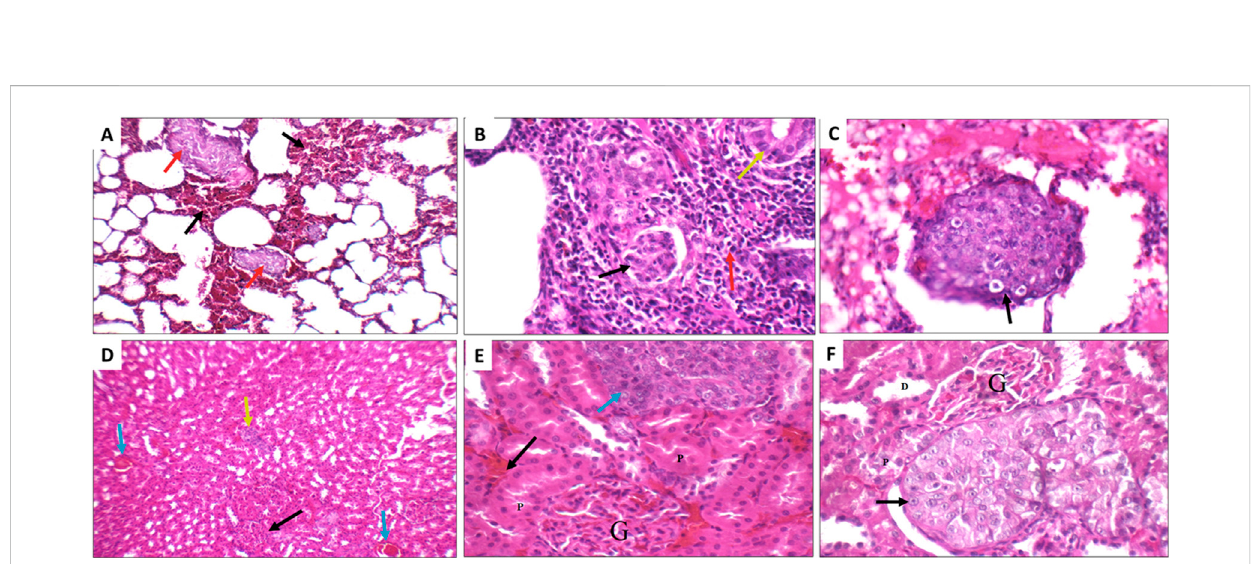
FIGURE 11 Metastatic nodules detected in the lungs (A – C) and kidneys (D – F) of the DEN rats from the different treatment groups. (A) Positive control lung showingmarkedinterstitial hemorrhage(blackarrow)withsmallmetastaticnodules(redarrow)(H&EX200). (B) Sorafenibtreatedratshowingmetastatic adenocarcinoma (yellow arrow), with marked in fl ammatory in fi ltrate (red arrow), and scattered tumour emboli (black arrow) (H&E X 400. (C) Fucoidan treated rats showing vascular tumour emboli (black arrow) (H&E X 400). (D) Sorafenib treated rat kidney showing average glomeruli (black arrow), areasofinterstitial hemorrhage(bluearrow),andmetastaticnodule(yellow arrow)(H&EX200). (E) Avastintreatedratshowingaverageglomeruli(G),and average proximal tubules (P), areas of interstitial hemorrhage (black arrow), and metastatic nodule (blue arrow) (H&E X 400). (F) Avastin treated rat showing average glomeruli (G), distal tubules (D) and average proximal tubules (P), and metastatic nodule of malignant cells with prominent nucleoli (black arrow) (H&E X